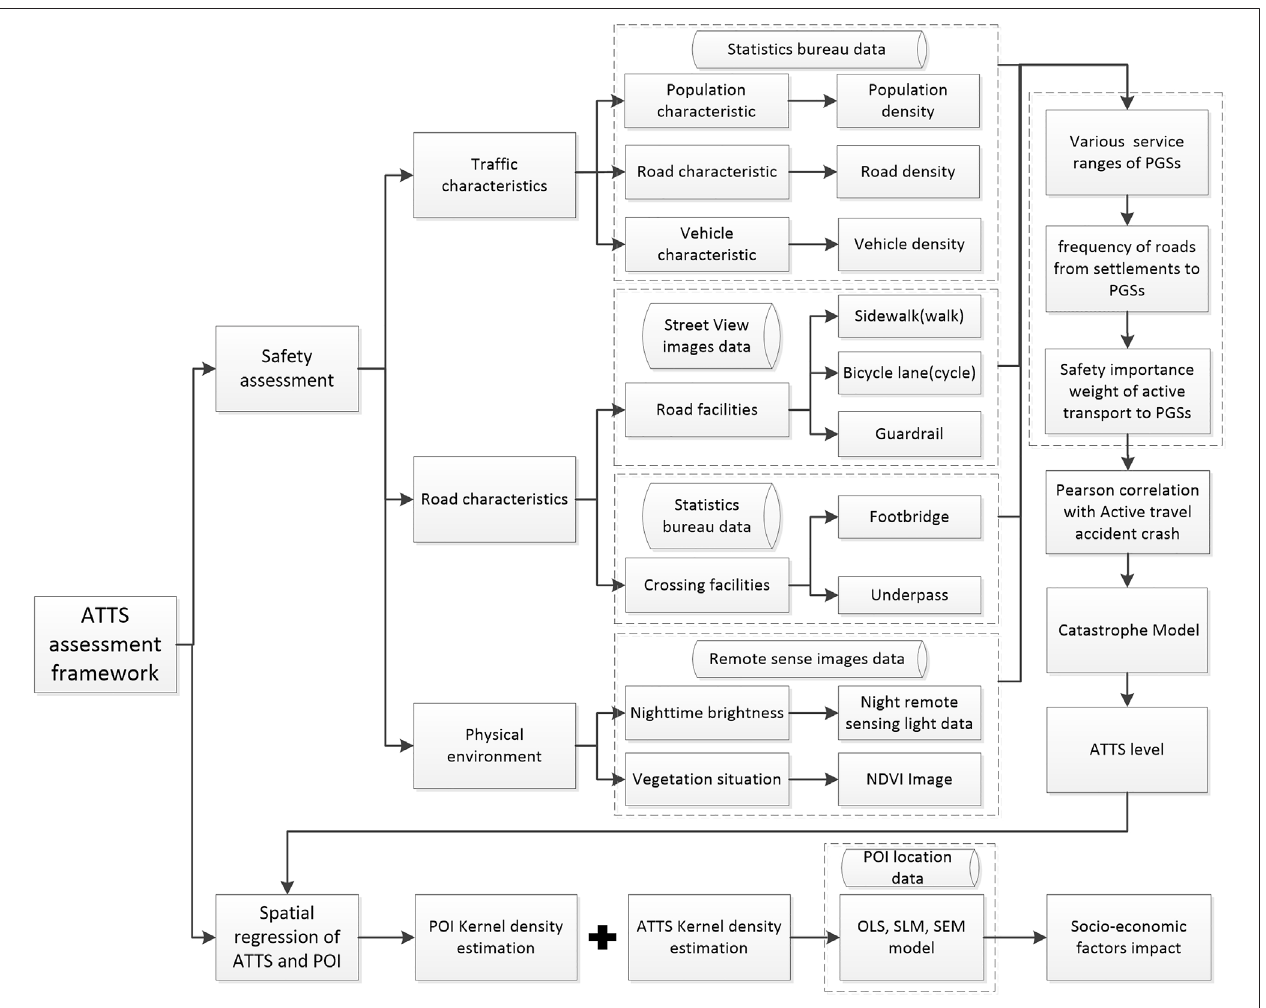
FIGURE 2 | ATTS assessment